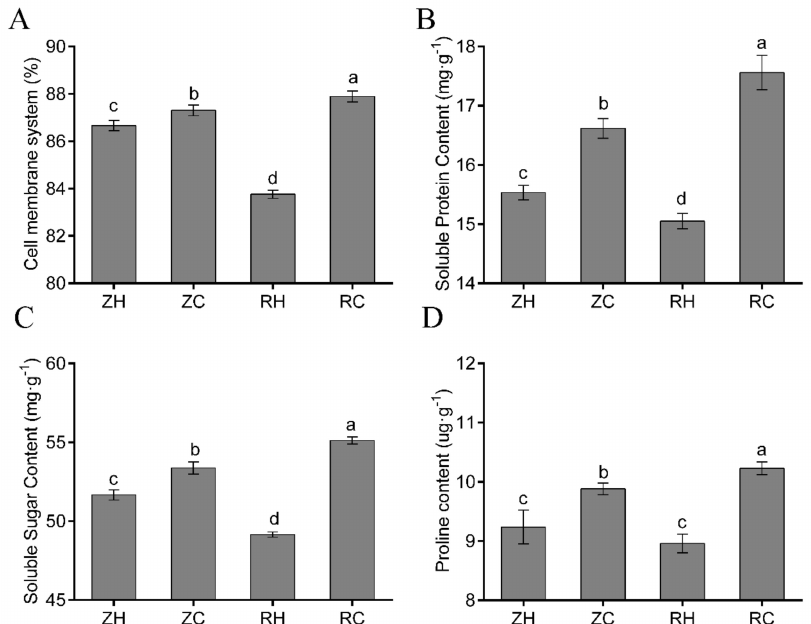
Figure 3. We determined the physiological indexes of Ca 2 + regulation in weak light. ( A ) Cell membrane system, ( B ) superoxide anion and soluble protein, ( C ) soluble sugar, and ( D ) proline were determined. Values represent the mean ± S.E. ( n = 3). Letters (a, b, c, d) indicate significant di ff erences at p < 0.05 according to Duncan’s multiple range tests.